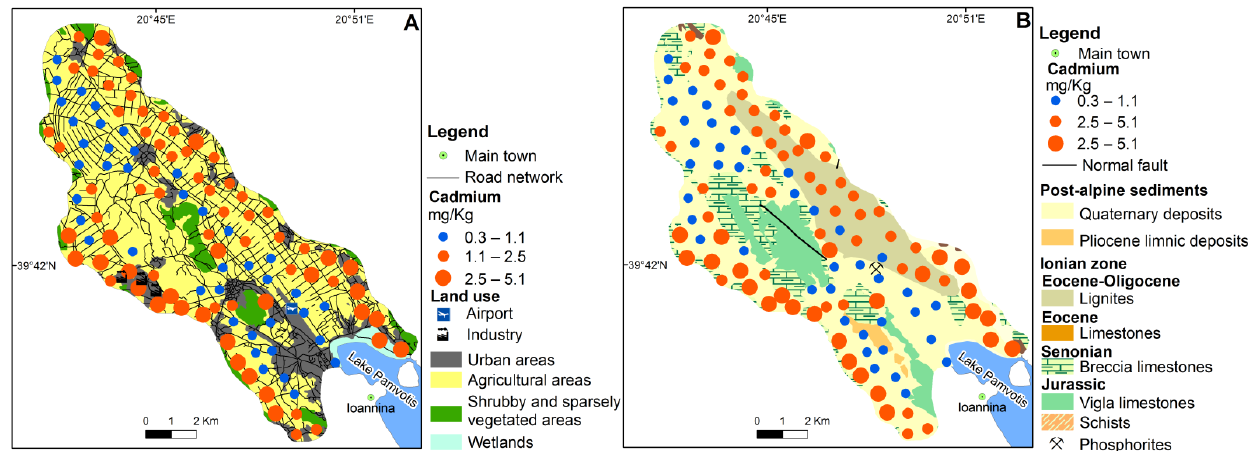
Figure 5. Graduated symbol plots of Cd content in soil of Ioannina plain concerning land uses ( A ) and geology ( B ).